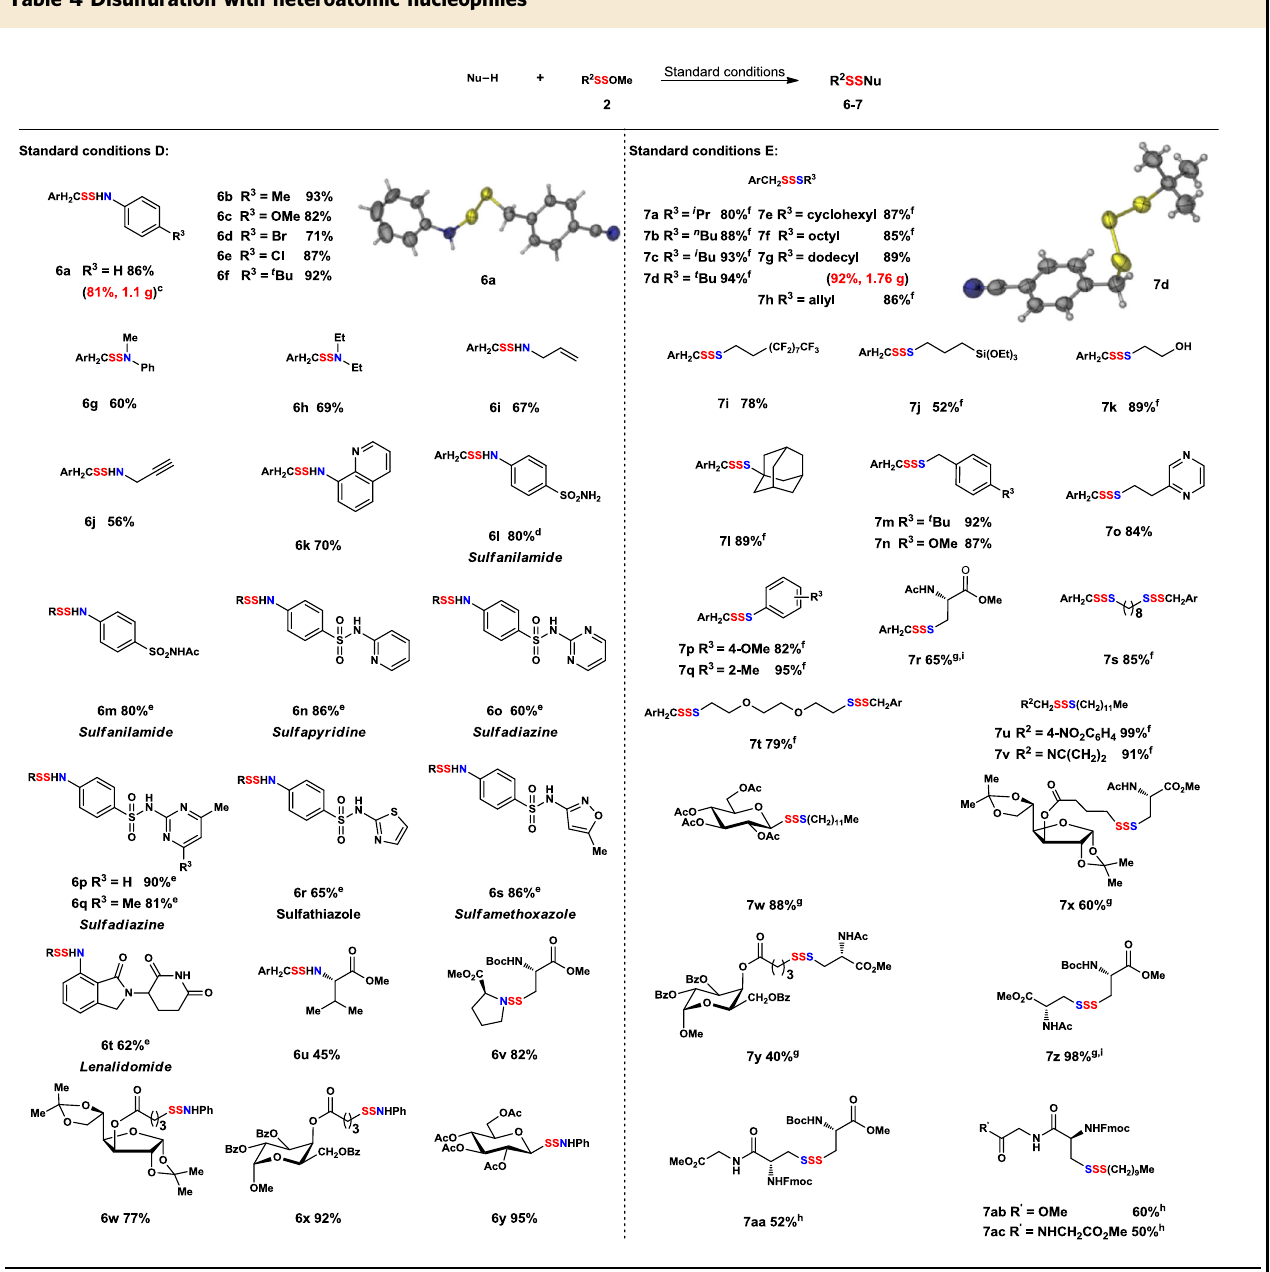
Table 4 Disulfuration with heteroatomic nucleophiles